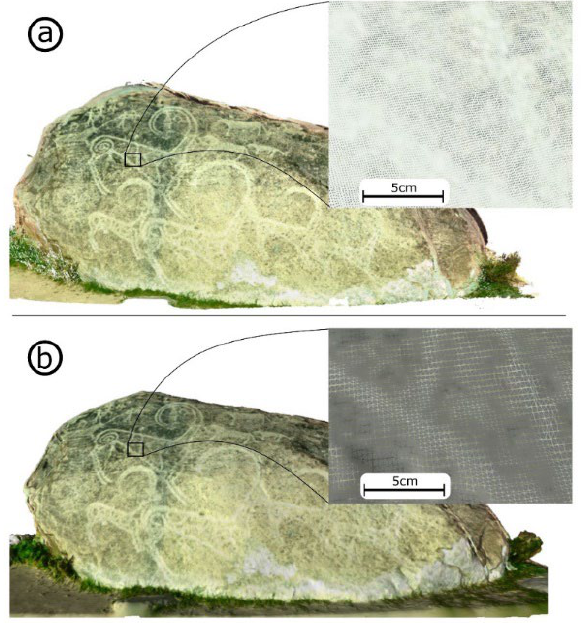
Figure 9. Examples of scanning results: ( a ) point cloud and ( b ) triangle mesh. Table 3. Parameters of point clouds and generated 3D meshes.